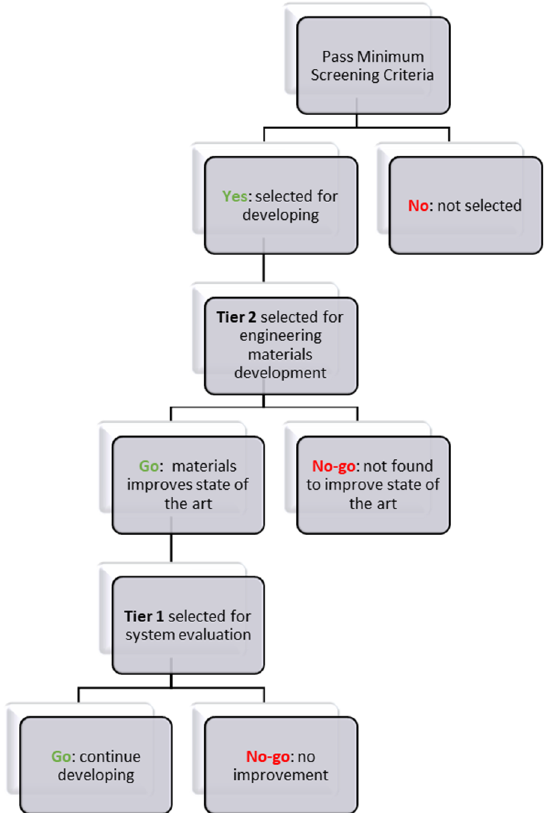
Figure 1. Materials selection procedure developed by the Hydrogen Storage Engineering Center of Excellence (HSECoE) to select candidates for engineering materials development and further system evaluation.